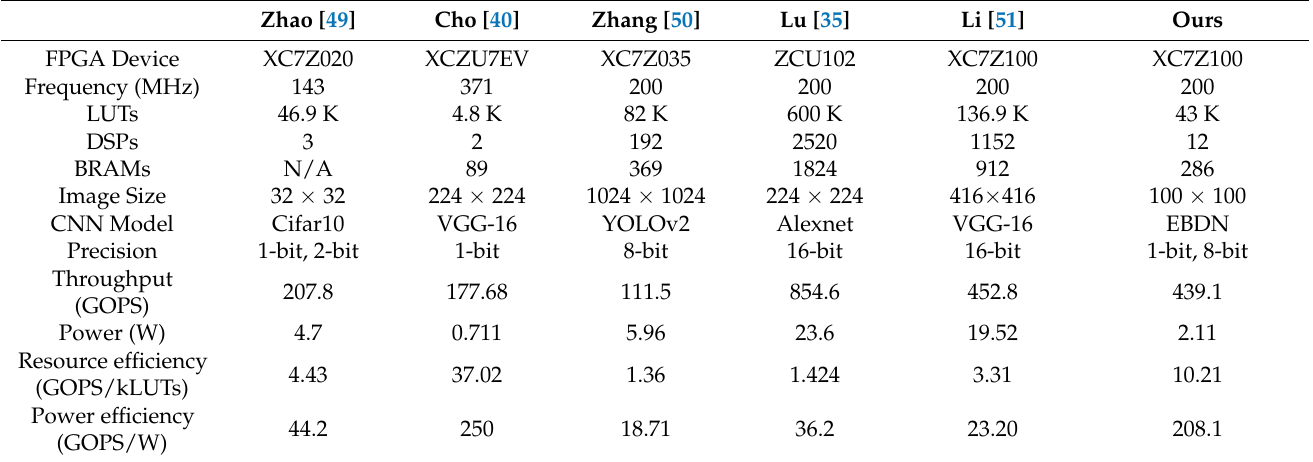
Table 4. Performance comparison of the proposed design with other previous CNN hardware architecture